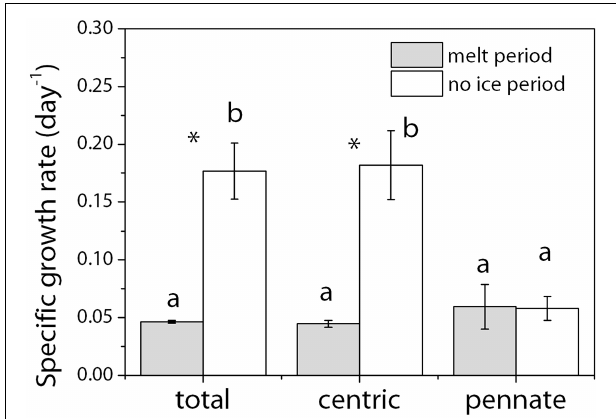
FIGURE 1 | Specific growth rate ( µ , day − 1 ) of different diatom groups during the ice-melt and no-ice period. The whole incubation was divided into two parts: the ice melt period and the no-ice period by t 31 . To calculate the growth rate in the no-ice period, cell abundance was natural log transformed before plotting against the day of incubation and the specific growth rate was calculated as the slope of the linearly fitted curve. To calculate the algal growth during the ice melt period, we assumed that the algal cells remaining in sea ice and those released into the seawater had the same growth rate. Gray, melt period; White, no-ice period. Mean values ( ± SD) are the average of four independent measurements. Alphabets indicate significant difference among different diatom groups. Stars indicate significant differences between the two incubation periods. ANOVA was used for comparisons. The significance level was 0.05.